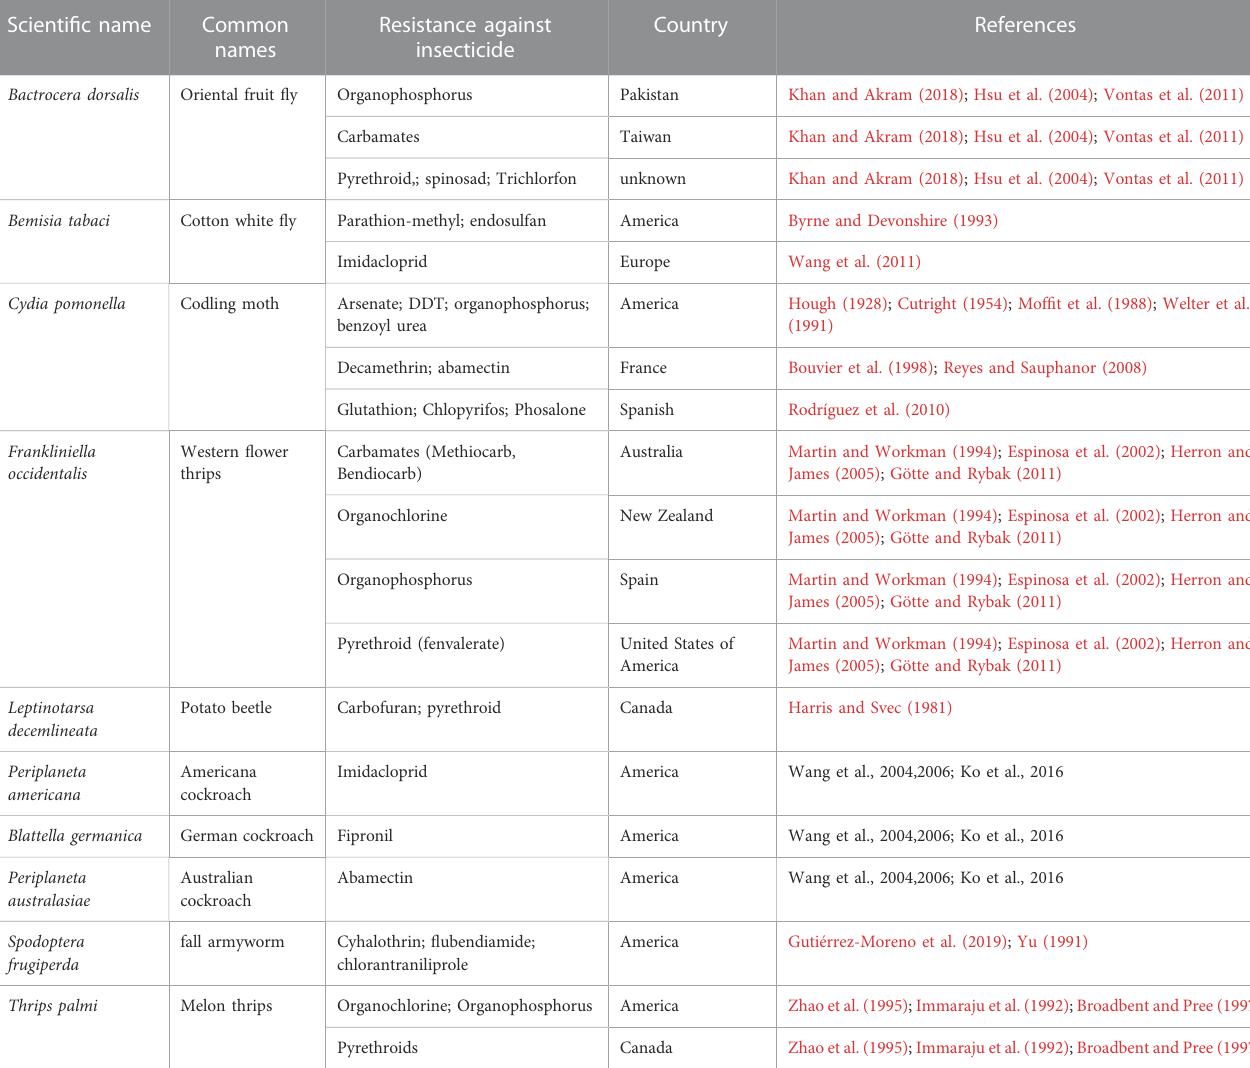
TABLE 2 A list of insecticide-resistant invasive species in the world.